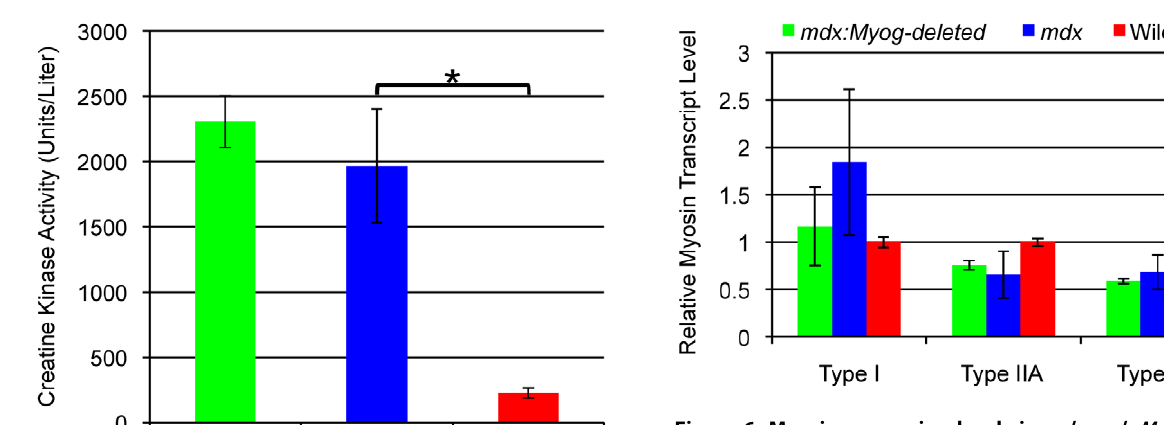
Figure 6. Myosin expression levels in mdx , mdx:Myog -deleted, and wild-type hindlimb muscle. No significant differences in transcript expression values, as assessed by RT-qPCR, for myosin isoforms type-I, type-IIa, and type-IIb were observed between mdx (n=3) and mdx:Myog -deleted (n=3) mice. Slight but significant alterations in myosins type-IIa and type-IIb were detected between wild-type (n=3) and mdx:Myog -deleted mice. Error bars represent 1 standard deviation (* p , 0.05).